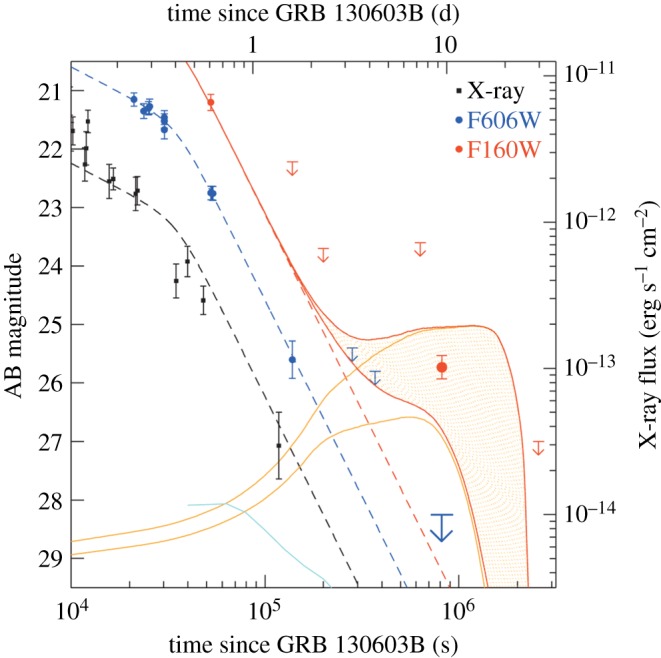
NIR, optical and X-ray light curve of the short GRB 130603B [166]. The corresponding optical AB magnitude and X-ray flux are given on the left and right axes, respectively. The optical (blue) and X-ray (black) afterglow light curves are well fitted with the same broken power law. Assuming the same post-break afterglow decay rate in the NIR (red), it is clear that an additional component is necessary to account for the detection at approximately 9 days after the GRB. The lower and upper orange curves correspond to predicted kilonova NIR light curves calculated from models with respective ejected masses of 10−2
M⊙ and 10−1
M⊙ [164], and the solid red curves are the corresponding emission from the GRB afterglow plus the kilonova. The cyan curve is the brightest optical emission predicted from an r-process kilonova, which is orders of magnitude dimmer than the GRB afterglow.